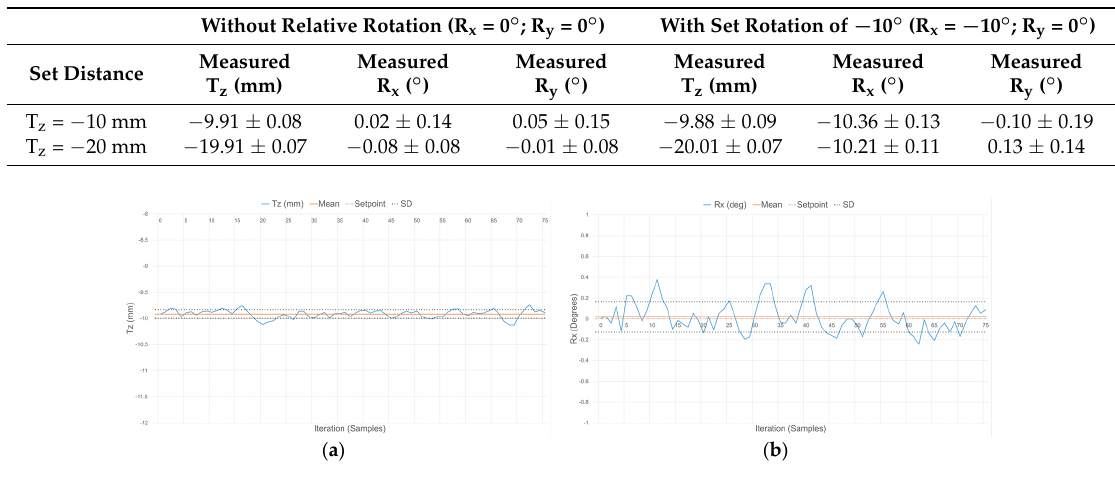
Figure 26. Response of the compliant wrist operating in contact mode while measuring: ( a ) distance to; and ( b ) relative orientation of the compliant plate matching that of a fixed planar surface, for a distance equivalent to − 10 mm and a surface perpendicular to the wrist’s main aiming direction (0°).